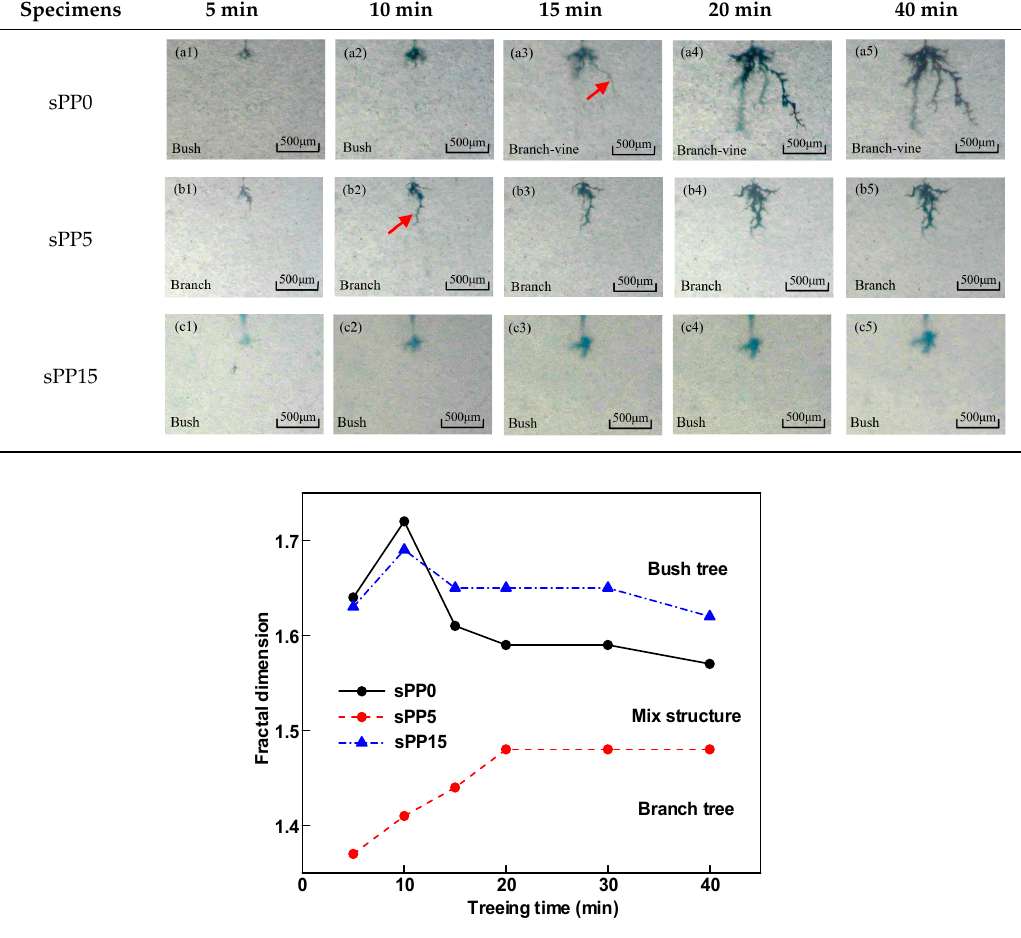
Table 3. Electrical tree morphology of iPP/sPP blends at 70 °C under AC voltage of 6 kV for 40 min. Specimens